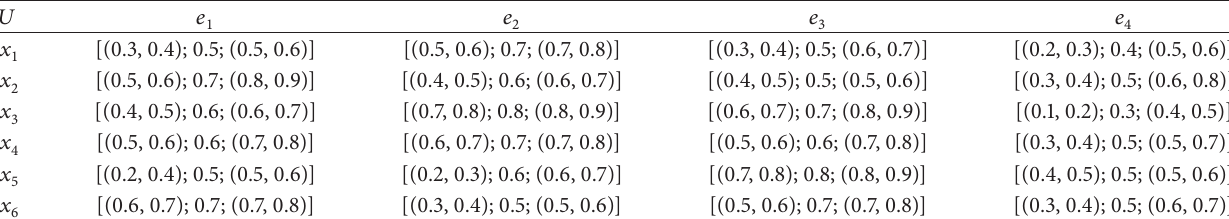
Table 1: An interval-valued triangular fuzzy soft set (𝐹,𝐴) .